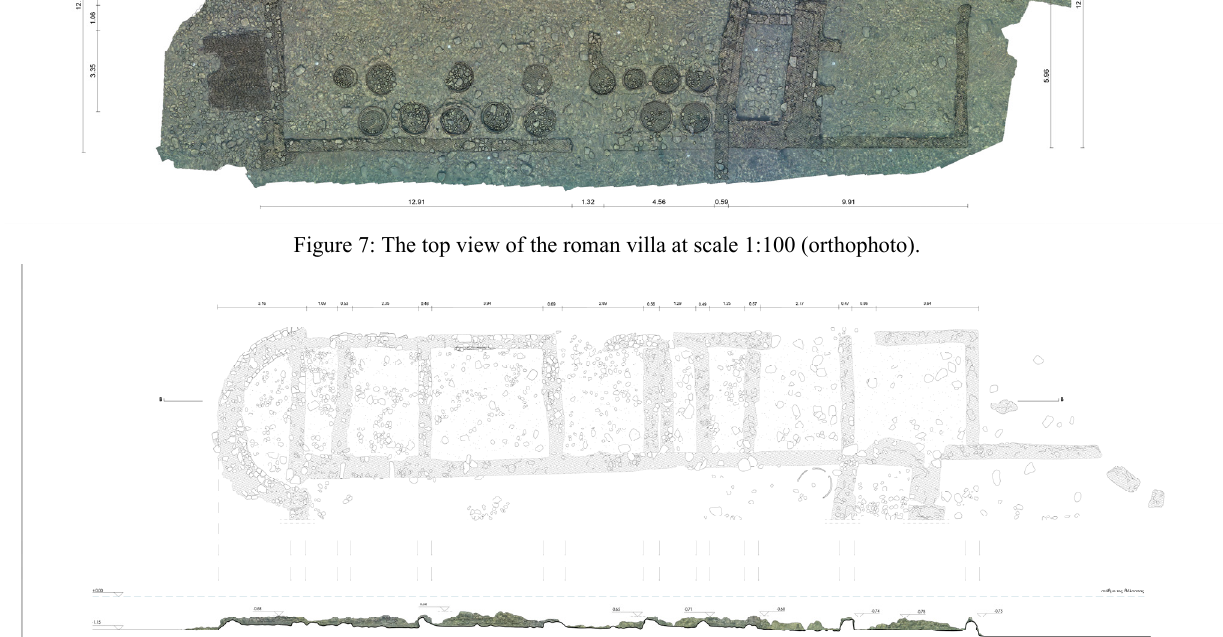
Figure 8: The horizontal section plan at scale